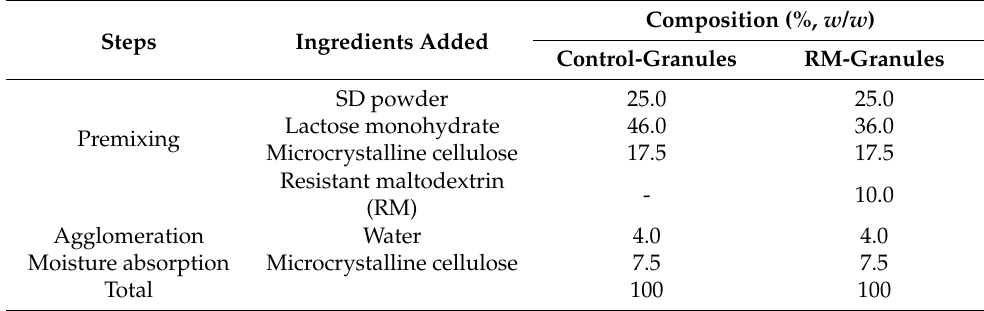
Table 3. Compositions of ingredients added during the high-shear granulation for the production of Control- and